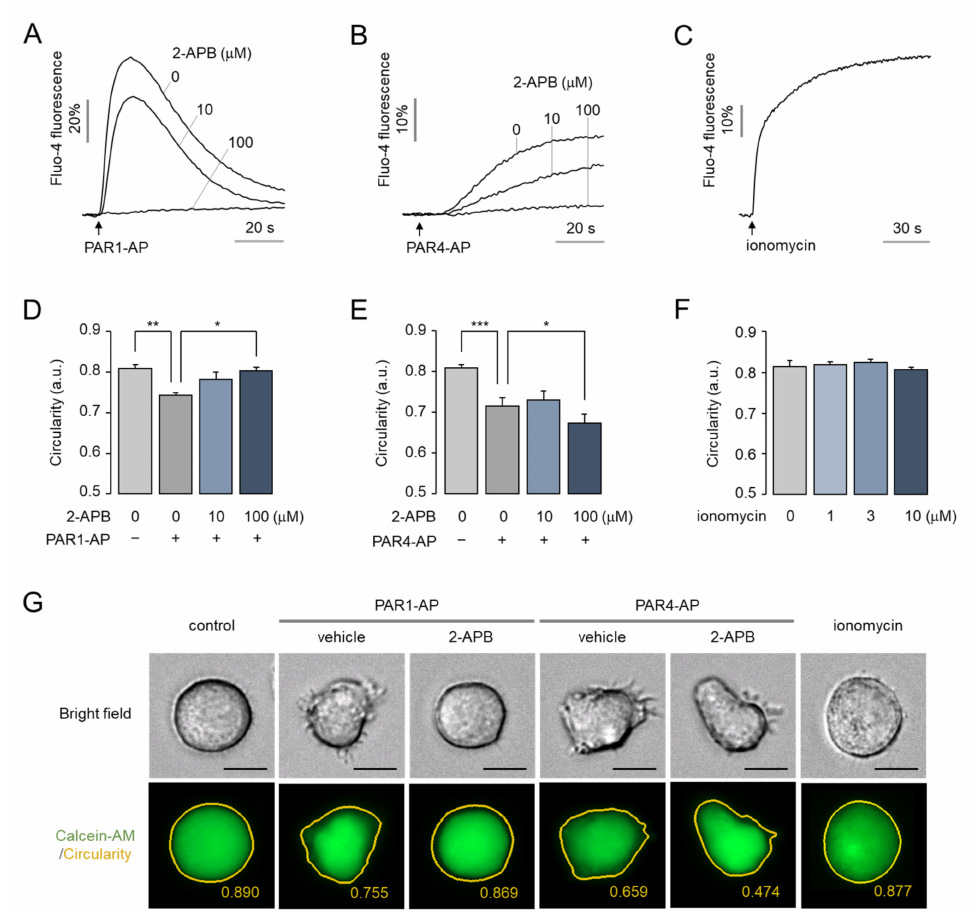
Figure 6. Effect of intracellular calcium signaling on morphological changes in MEG-01 cells. ( A , B ) Inhi- bition of PAP1-AP- and PAR4-AP-induced intracellular calcium increase by 2-APB. MEG-01 cells were pre-treated with 2-APB at the indicated concentrations prior to applying 100 µ M of PAR1-AP ( A ) or PAR4- AP ( B ). ( C ) Measurement of ionomycin (10 µ M)-induced intracellular calcium increase. ( D – F ) Summary of morphological changes. MEG-01 cells were pre-treated with 2-APB at the indicated concentrations for 30 min prior to applying 100 µ M of PAR1-AP ( D ) or PAR4-AP ( E ), and ionomycin was applied at the indicated concentrations for 30 min ( F ). ( G ) Representative images of MEG-01 cells. Cells were pretreated with 100 µ M of 2-APB for 30 min, and then PAR1-AP (100 µ M) and PAR4-AP (100 µ M) were applied for 30 min or treated with ionomycin (10 µ M) for 30 min. Calcein-AM-stained images were captured automatically and circularity was measured using Lionheart software (mean ± S.D., n = 4). Scale bar = 10 µ m. * p < 0.05, ** p < 0.01, *** p <